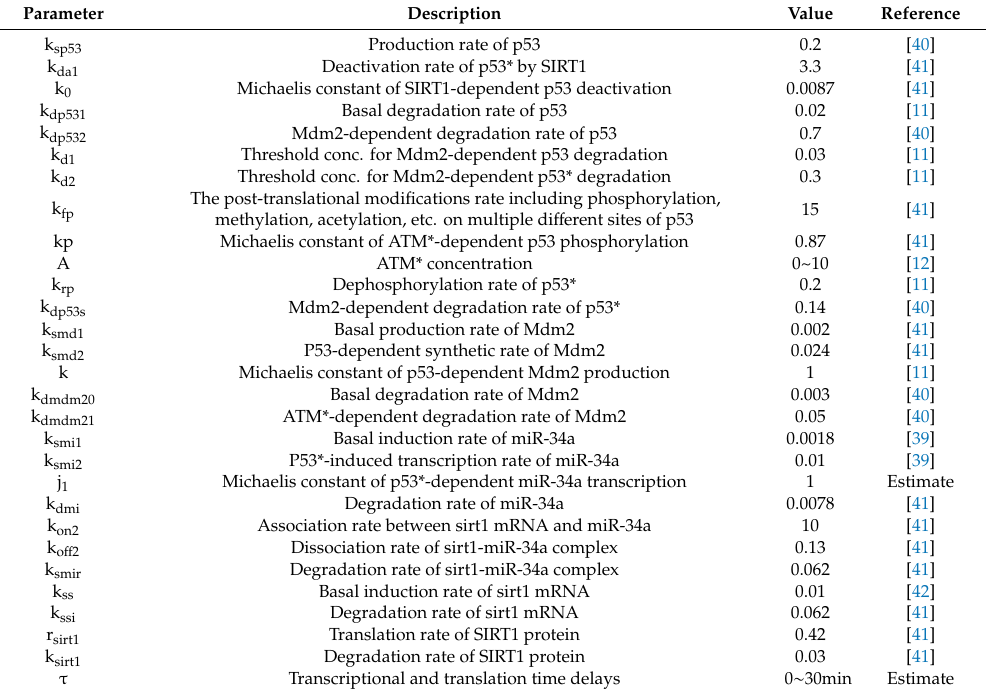
Table 1. Parameters values used in numerical